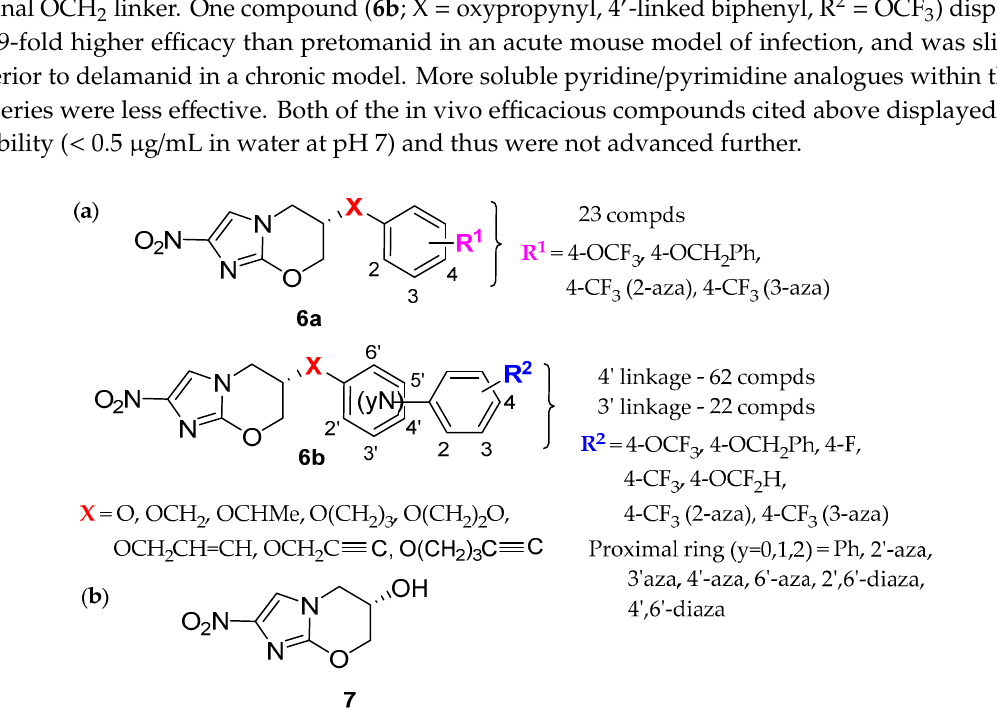
Figure 3. ( a ) Subseries ( 6a , 6b ) of novel pretomanid analogues with variable ether linkers (X); ( b ) Toxic metabolite 7 .